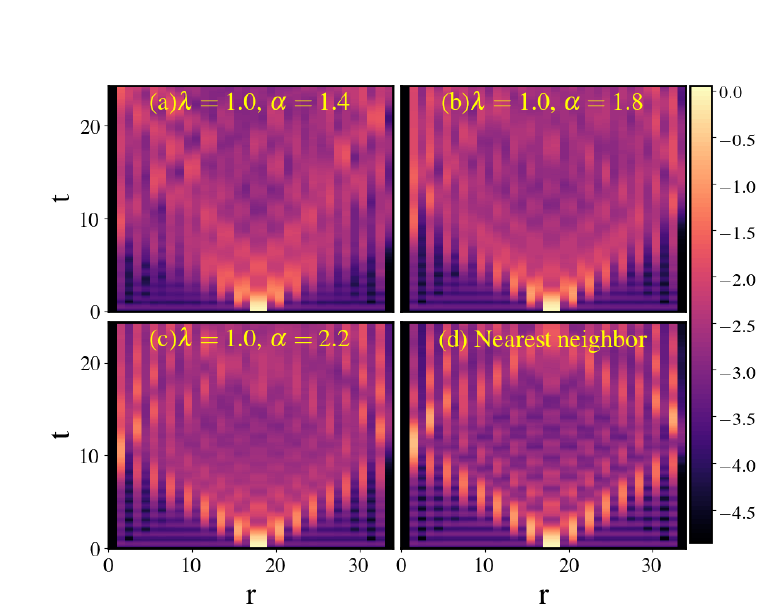
Figure 10: Spinon density 〈 N ↑ ( r , t ) N ↑ ( r + 1, t ) 〉 for λ = 1 and different values of α , obtained using Villain’s approximation including three spinons and one anti-spinon.